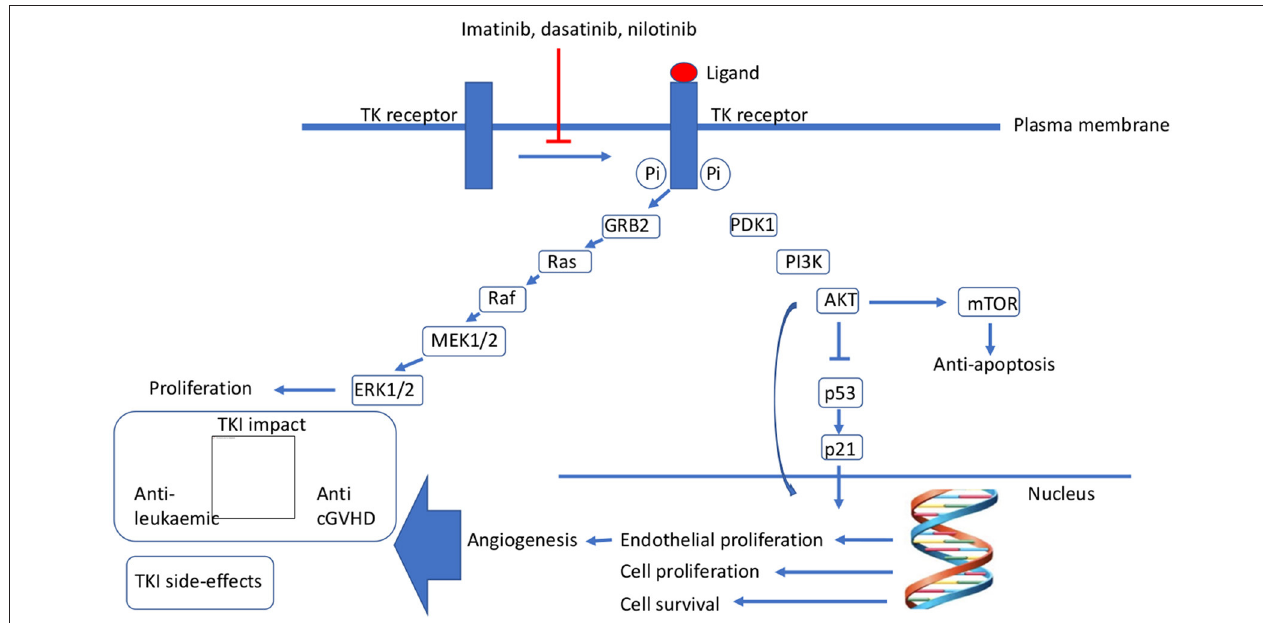
FIGURE 1 | Mechanism of action of tyrosine kinase inhibitors. AKT, protein kinase B; cGvHD, chronic graft-vs.-host disease; ERK1/2, extracellular signal-regulated kinase 1/2; GRB2, growth factor receptor-bound protein 2; MEK1/2, mitogen-activated protein kinase 1/2; mTOR, mammalian target of rapamycin; Pi,